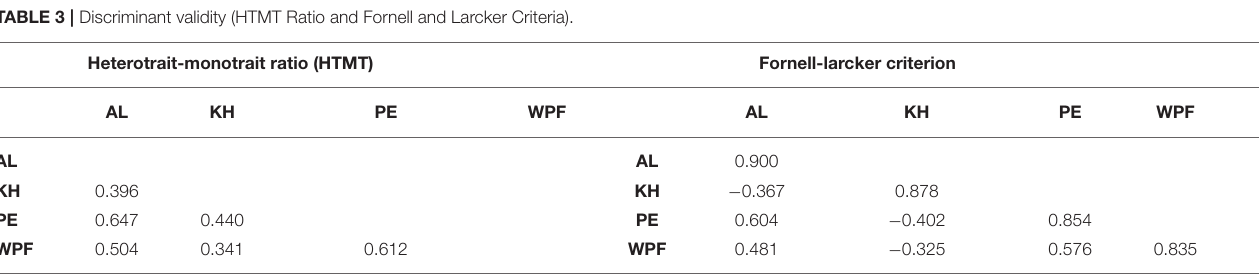
TABLE 3 | Discriminant validity (HTMT Ratio and Fornell and Larcker Criteria). Heterotrait-monotrait ratio (HTMT) Fornell-larcker